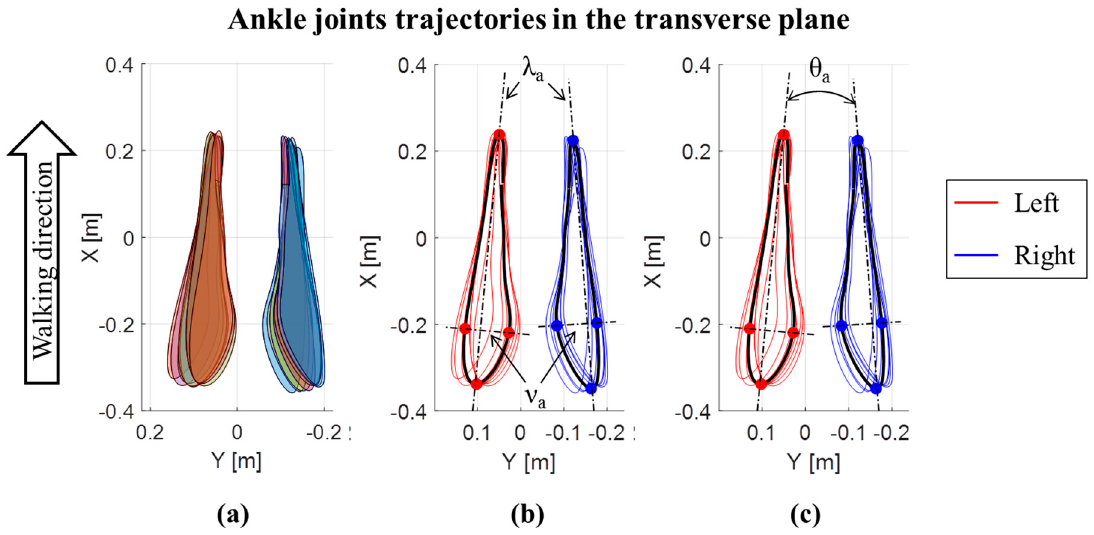
Figure 3. Ankle joints trajectories in the transverse plane for an OW subject: ( a ) Area of each left and right step; ( b ) major ( λ k ) and minor ( ν k ) diameters of the average ankle joints trajectories; ( c ) ankle opening angle ( θ a ) between the left and right major axes of average ankle joint trajectories.